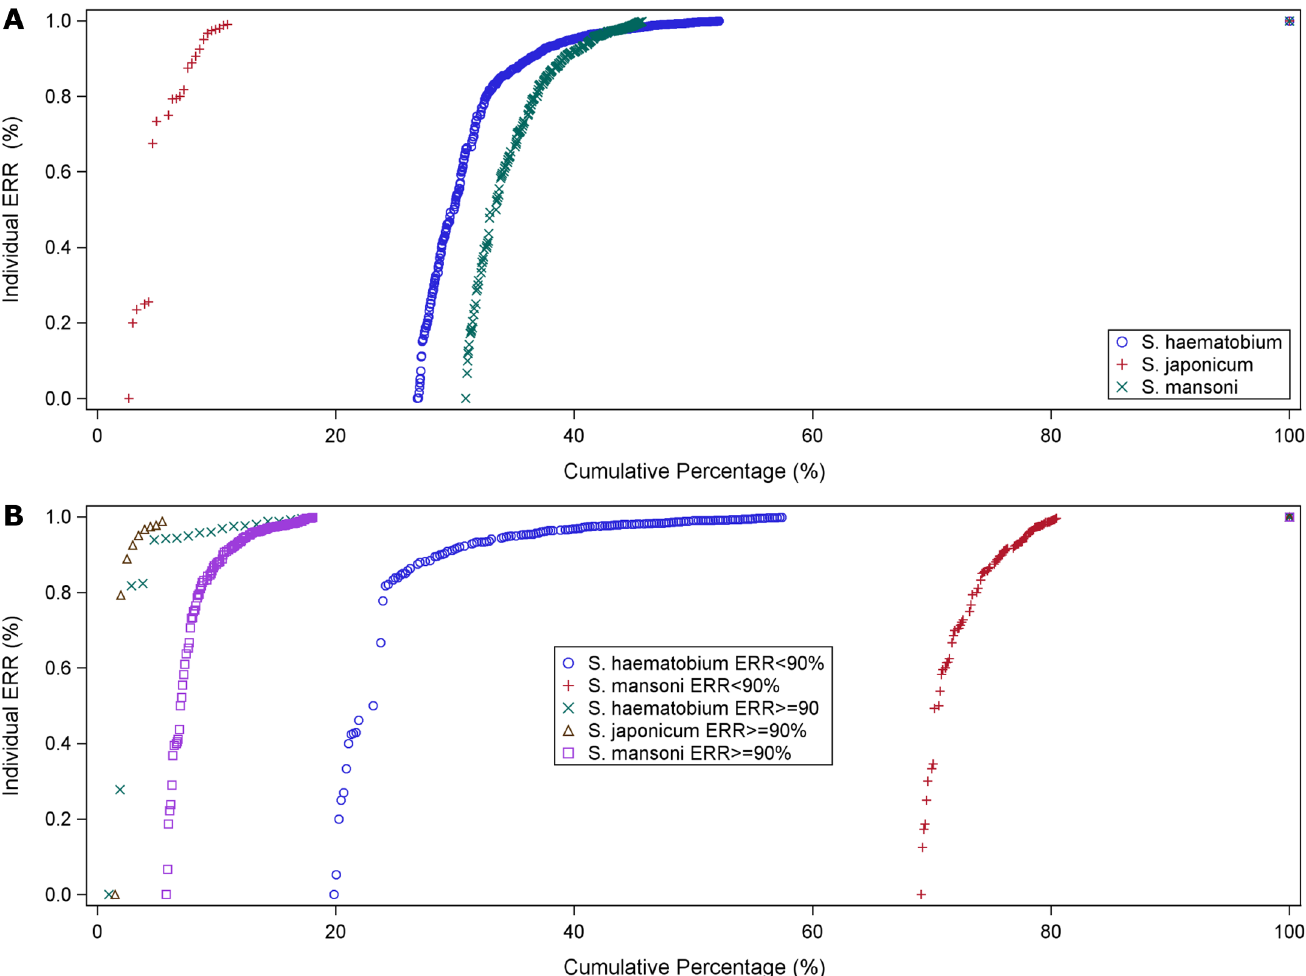
Fig 4. Centile distribution of individual ERRs by species for all studies (A) and for studies with assessment within 28 days divided by ERR AM (cid:3) 90% and < 90% (B).